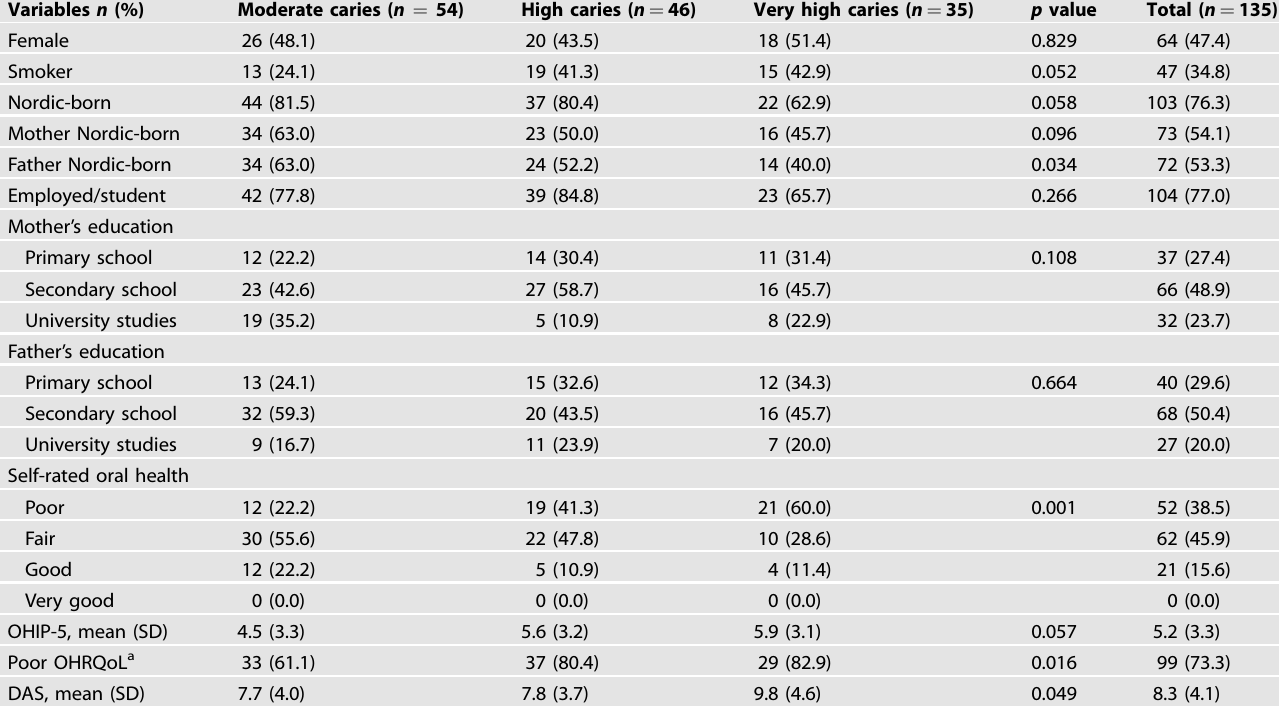
Table 1. Sociodemographic characteristics, self-rated oral health, OHRQoL (measured by the OHIP-5), and dental anxiety (measured by the DAS) according to caries severity: moderate caries (2 – 3 lesions), high caries (4 – 6 lesions), very high caries ( ≥ 7 lesions), and for the total